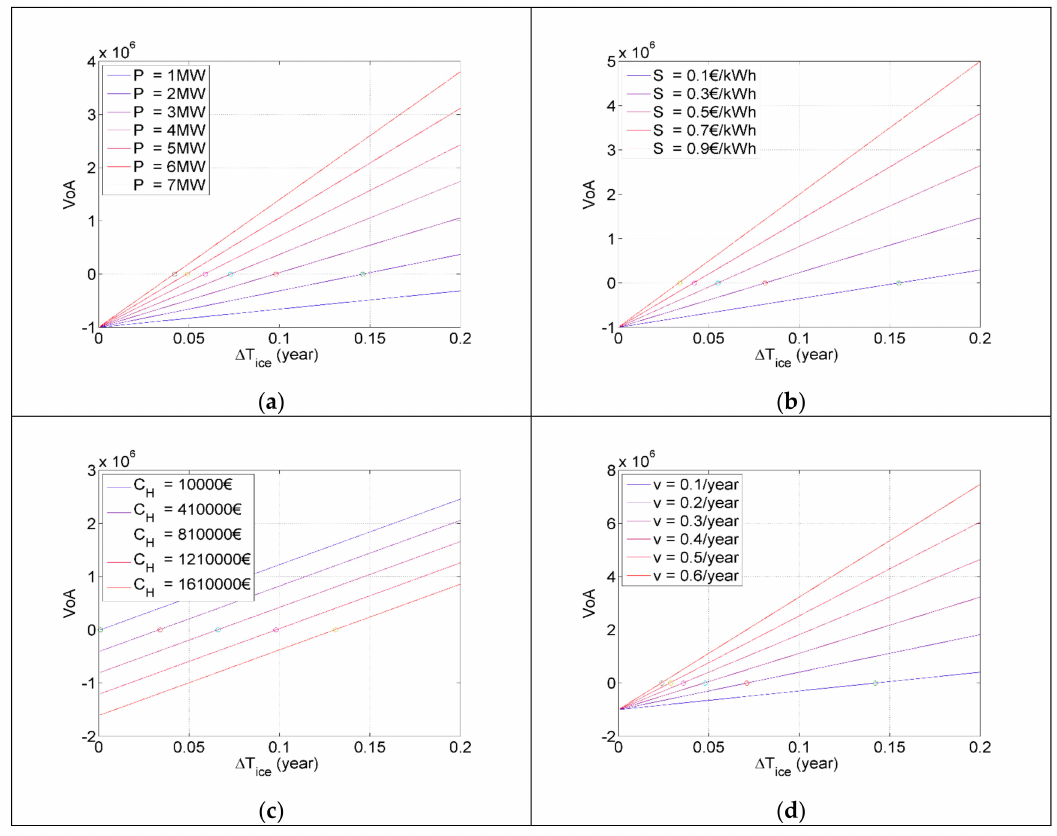
Figure 10. Parametric analysis regarding Value of Action (VoA) with respect to the power of the wind turbine ( a ), electricity price ( b ), cost of the heating system ( c ), and number of icings per year ( d